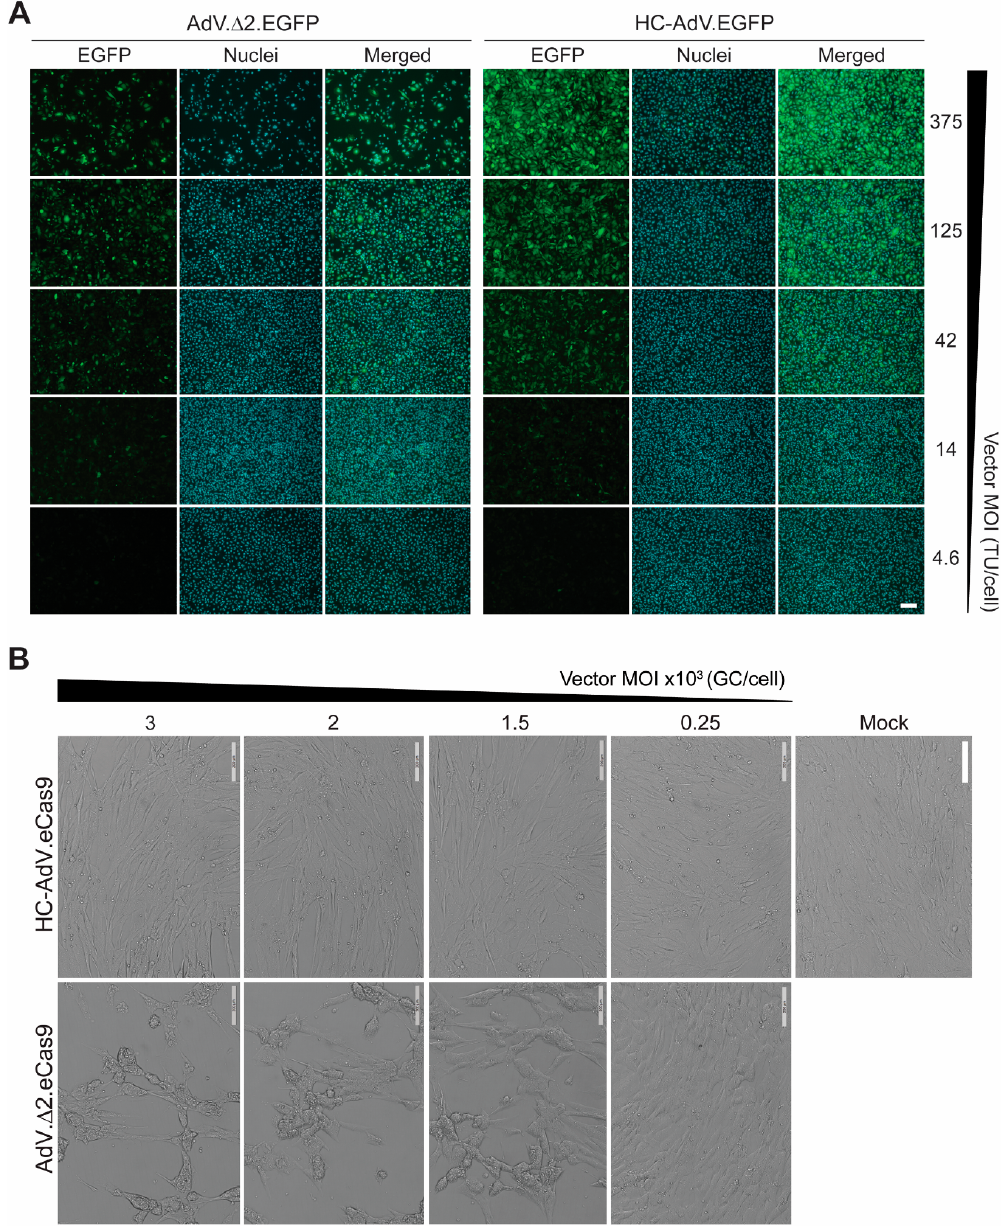
Figure 3. Comparing the impact of second-generation versus third-generation AdVs on human cells. ( A ) Direct fluorescence microscopy on HeLa cell cultures. HeLa cells were transduced with AdV. ∆ 2.EGFP or with HC-AdV.EGFP at the indicated multiplicities of infection (MOI) and were then subcultured at 2 days post-transduction. At 3 days post-transduction, total and transgene-positive cells present in randomly selected microscopy fields were detected through fluorescence microscopy directed to the DNA dye Hoechst 33342 and EGFP, respectively. TU / cell: transducing units per cell. ( B ) Bright-field microscopy on human myoblast cultures. Human DMD. ∆ 45–52 myoblasts were transduced with AdV. ∆ 2.EGFP or with HC-AdV.EGFP at the indicated multiplicities of infection (MOI) and were then subcultured at 3 days post-transduction. Bright-field microscopy images were acquired at 5 days post-transduction. GC / cell: genome copies per cell. Magnification bars correspond to 200 µ